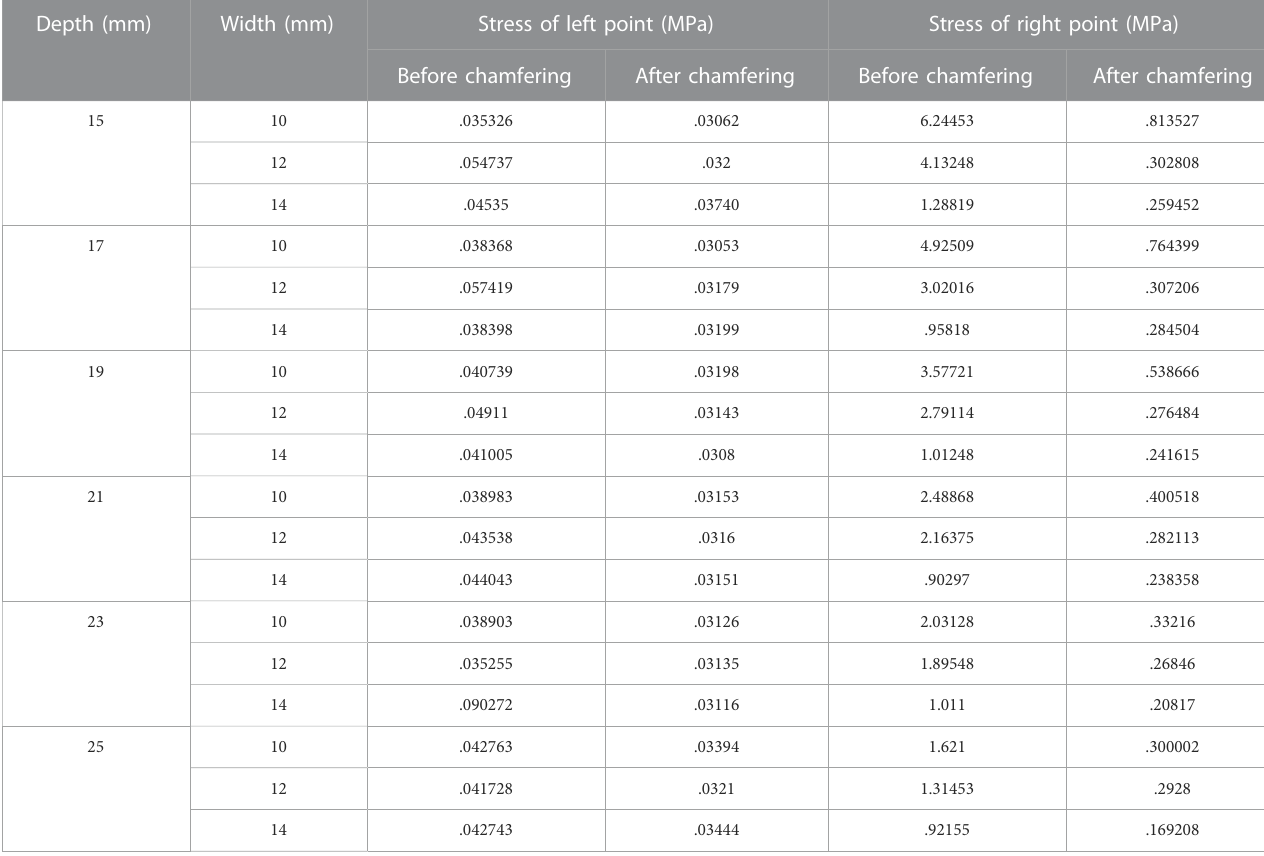
TABLE 6 Induced stress at left and right measurement positions following the removal of the orbital wall with a rectangular shape. Depth (mm) Width (mm) Stress of left point (MPa) Stress of right point (MPa) Before chamfering After chamfering Before chamfering After